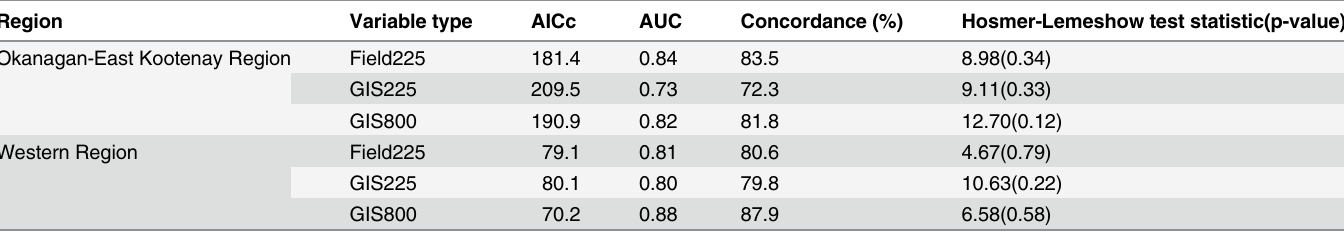
For the Field225, GIS225, and GIS800 models in each region, comparative statistics are given: Akaike ’ s Information Criterion corrected for small sample sizes (AICc), area under the curve (AUC) of receiver operating characteristic, percentage of concordant pairs (Concordance) and the Hosmer-Lemeshow test statistic with the associated